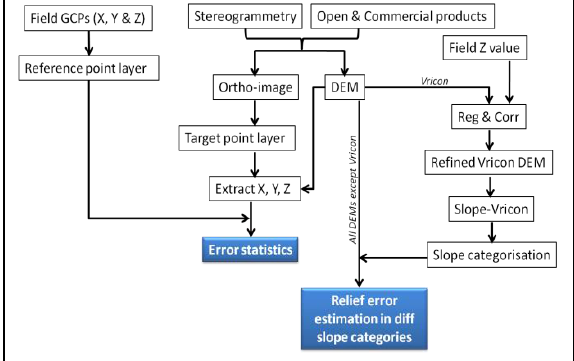
Figure 3 Flow chart depicting the methodology adopted during the